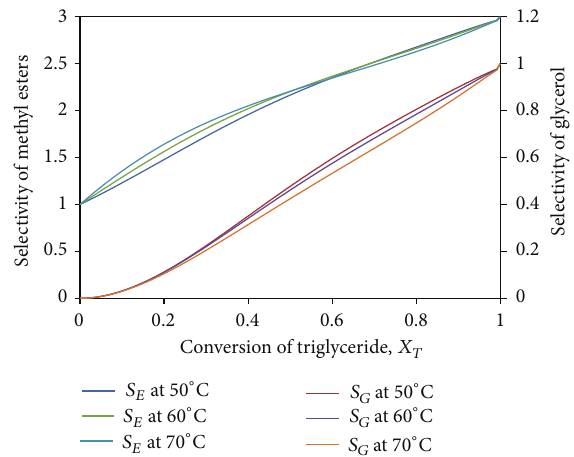
Figure 4: Selectivity of methyl ester at various temperatures and fixed molar ratio and catalyst concentration for Case